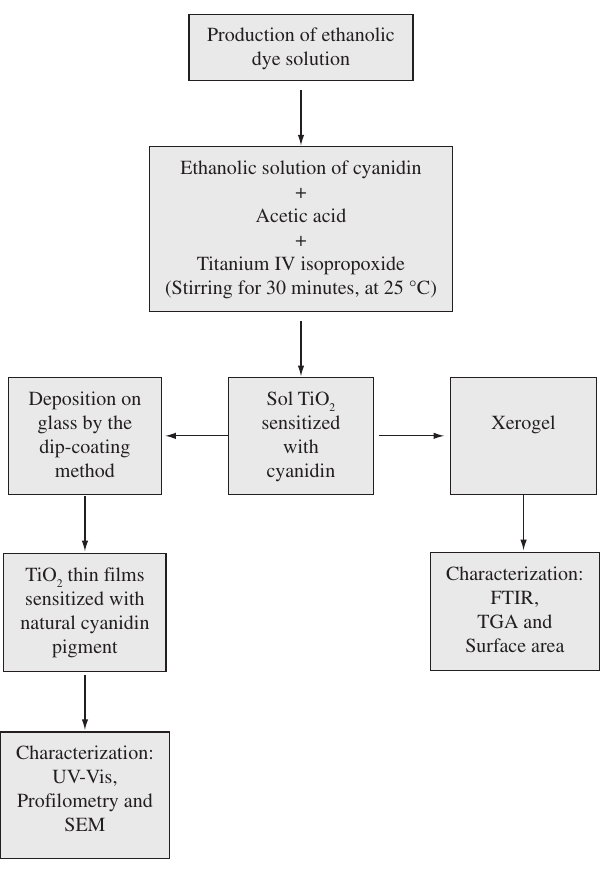
Figure 2. Flowchart of the